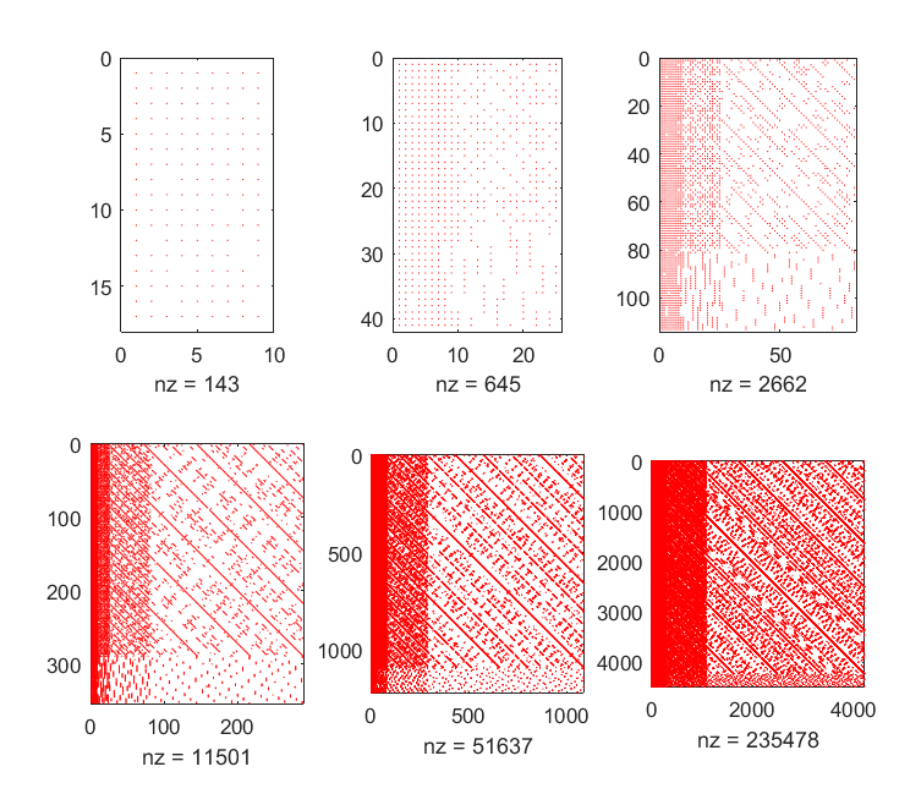
Figure 4. Helmholtz problem: Sparsity behavior of discrete matrices by H-RBFs collocation at levels 1, 2, 3, 4, 5, and